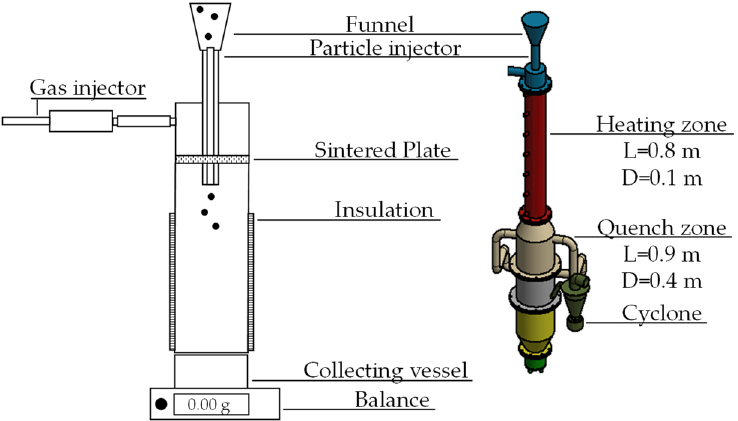
Figure 1. Schematic representation of the experimental apparatus of the downer reactor and an isometric view of the apparatus.